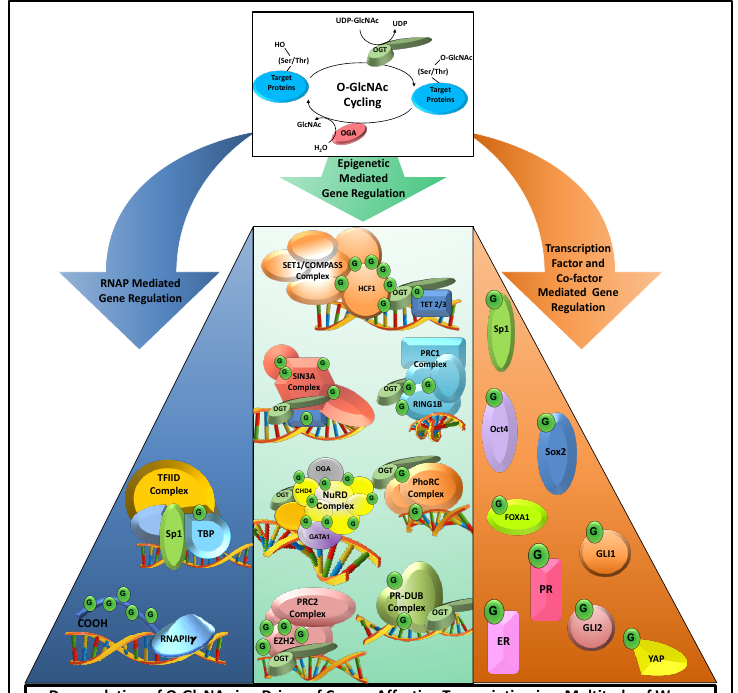
Figure 6. Dysregulation of O-GlcNAc is a driver of cancer by affecting transcription. O- GlcNAcylation is a nutrient-sensitive PTM that modulates gene transcription (green circle “G”). O-GlcNAcylation of the RNAP II CTD affects transcription initiation. It is also found on TBP and numerous RNAP core transcriptional proteins which connects nutrient flux to gene expression. O-GlcNAcylation also influences epigenetic gene regulation via regulation of the SET1/COMPASS, SIN3A, NuRD, PRC1, PRC2, PhoRC, and PR-DUB complexes. Additionally, many transcription factors such as Sp1, Oct4, Sox2, FOXA1, PR, ER, GLI 1, GLI2, and the co-activator YAP all require O-GlcNAcylation to properly regulate their target genes. In general, O-GlcNAcylation of RNAP II, RNAP accessory transcription factors, co-activators, co-repressors, and lineage-specific transcription factors affect their activity, localization, and/or stability. All cancers exhibit aberrant O-GlcNAcylatio; dysregulation of O-GlcNAcylation triggers or exacerbates cancer phenotypes by disrupting normal gene